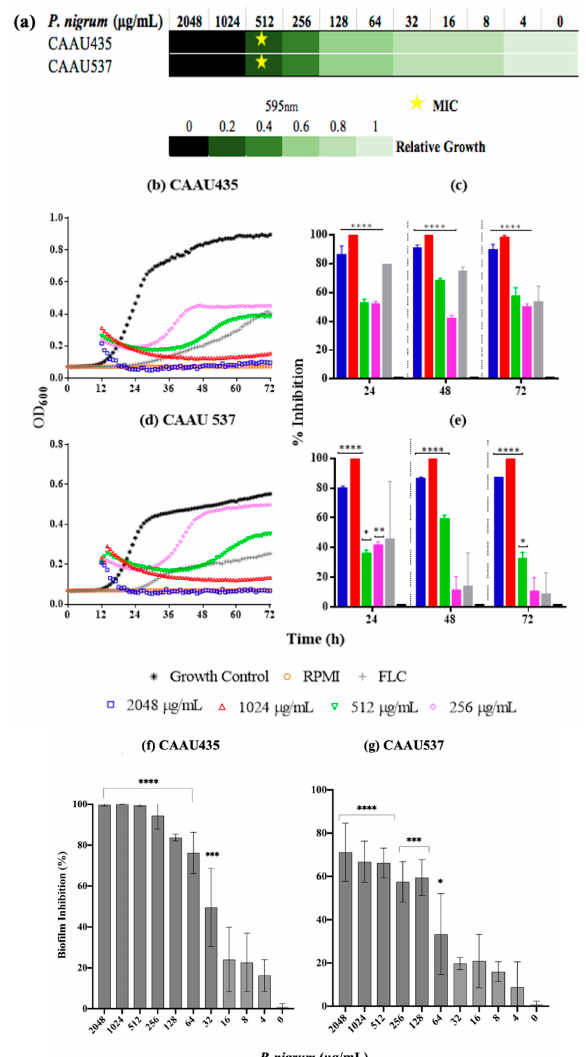
Figure 9. Anticandidal activity of P nigrum on C. auris . ( a ) P nigrum MICs (indicated by stars), the green bars indicate relative fold growth. ( b , d ) Killing kinetics curves ( c , e ) percentage of growth inhibition. ( f , g ) inhibitory activity against biofilm development. Control bar indicates untreated cells, accepted as 0% inhibition (0 µg/mL). p -values of <0.05 were used to indicate statistical significance as follows: * p ≤ 0.05. ** p ≤ 0.01. *** p ≤ 0.001. **** p ≤ 0.0001.